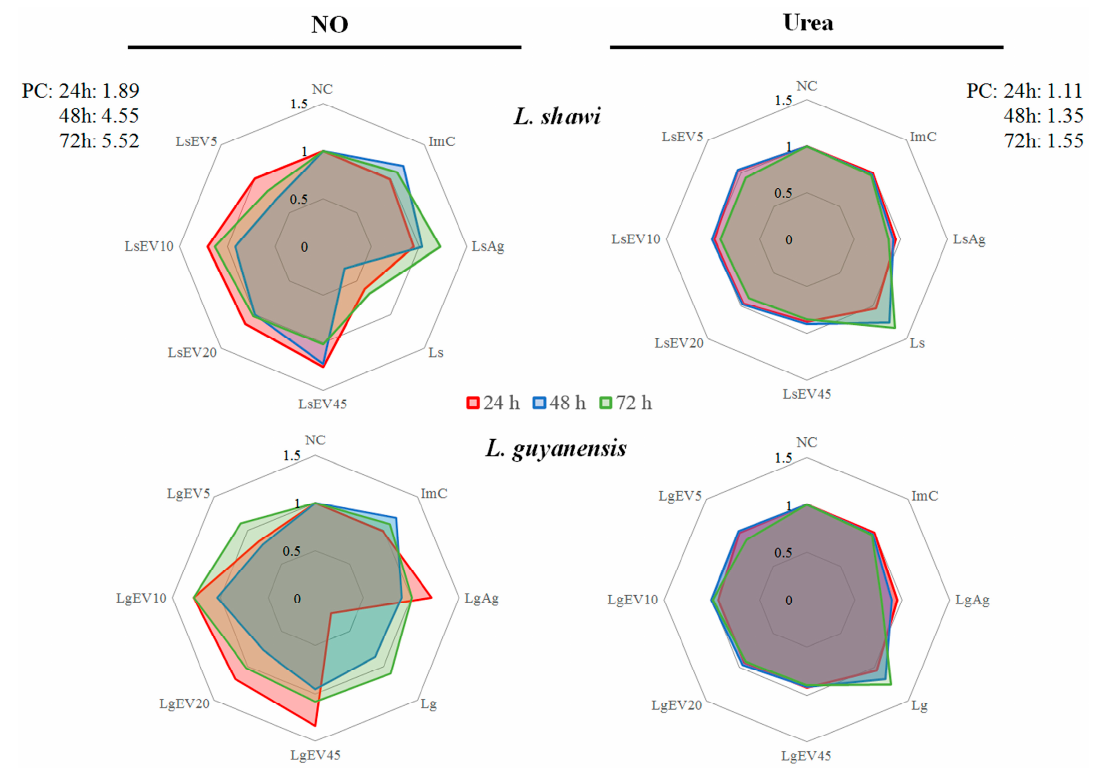
Figure 9. E ff ect of L. shawi and L. guyanensis EVs on NO and de novo urea production. M Ф incubated for 24 h, 48 h, and 72 h with 5 (LsEV5; LgEV5), 10 (LsEV10; LgEV10), 20 (LsEV20; LgEV20), and 45 µg·mL − 1 (LsEV45; LgEV45) of EVs from L. shawi and L. guyanensis , parasite antigens (LsAg and LgAg), and L. shawi (Ls) and L. guyanensis (Lg) promastigotes were analyzed by colorimetric assays. Fold change (to resting M Ф ) results of three independent assays performed in triplicate are represented by radar graph. NC—negative control (resting M Ф ); Positive control (PC -; M Ф incubated with PMA). ; ImC—M Ф incubated with negative control of EV isolation method.